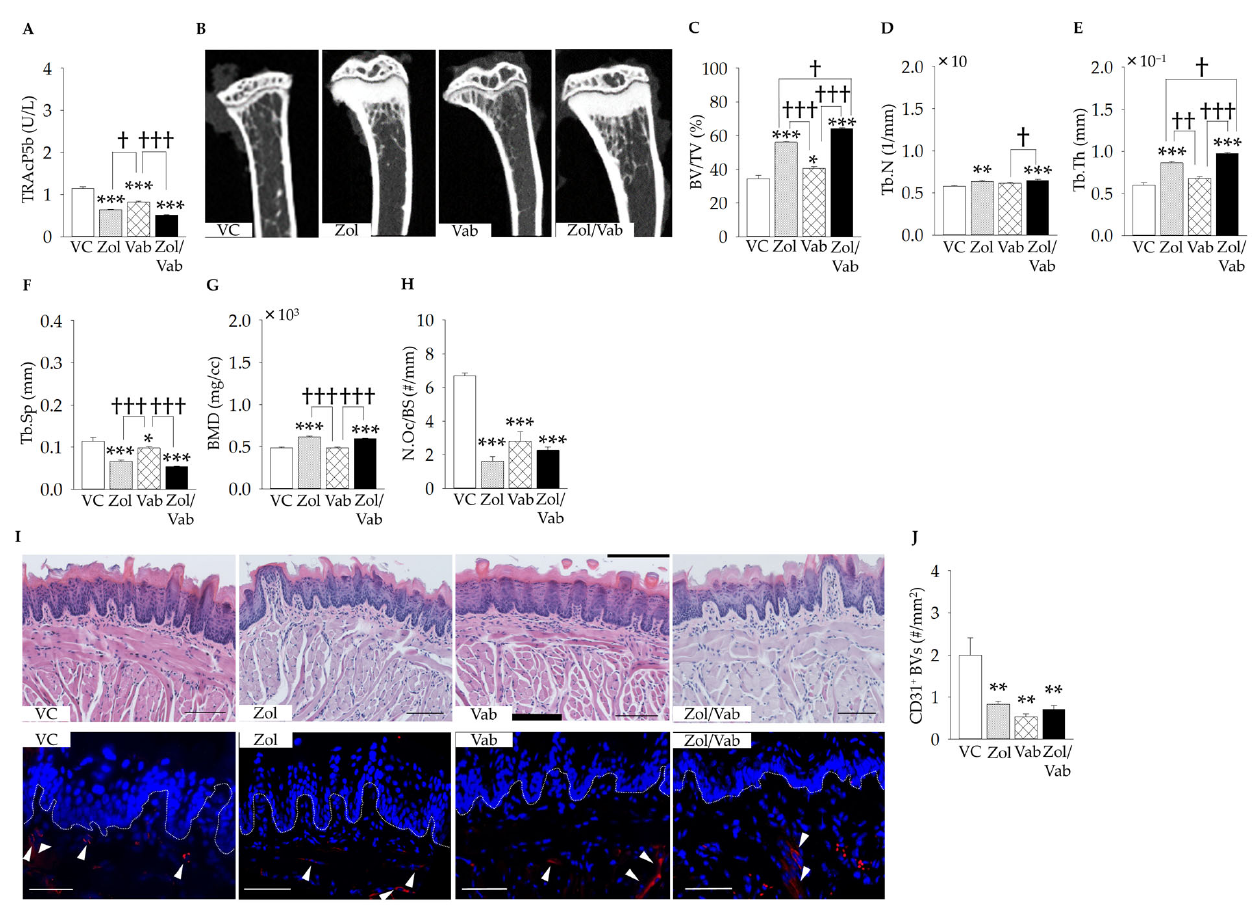
Figure 2. Effects of administered drugs on systemic conditions. ( A ) Serum TRAcP5b levels are significantly lower in Zol, Vab, and Zol/Vab vs. VC, and in Zol and Zol/Vab vs. Vab. ( B ) Representative micro computed tomography images of the tibial metaphysis. ( C ) Bone volume per tissue volume (BV/TV) is significantly larger in Zol/Vab vs. other comparison groups, whereas BV/TV is significantly larger in Zol and Vab vs. VC, and in Zol vs. Vab. ( D ) Trabecular number (Tb.N) is significantly increased in Zol/Vab vs. VC and Vab, and Zol vs. VC. ( E ) Trabecular thickness (Tb.Th) is significantly greater in Zol/Vab vs. other comparison groups, whereas Tb.Th is significantly greater in Zol vs. VC and Vab. ( F ) Trabecular separation (Tb.Sp) is significantly smaller in Zol, Vab and Zol/Vab vs. VC, and in Zol and Zol/Vab vs. Vab. ( G ) Bone mineral density (BMD) is significantly greater in Zol and Zol/Vab vs. VC and Vab, although BMD is the same in Vab and VC. ( H ) The number of osteoclasts on the bone surface (N.Oc/BS) is significantly decreased in Zol, Vab, Zol/Vab vs. VC. ( I ) Representative hematoxylin and eosin-stained and immunofluorescent images of tongue tissue (white arrowheads: CD31 + cells, bar: 100 µ m). ( J ) The number of CD31 + blood vessels (CD31 + BVs) is significantly decreased in Zol, Vab, and Zol/Vab vs. VC. Graphs show means ± SEM. * p < 0.05, ** p < 0.01, *** p < 0.001, † p < 0.05, †† p < 0.01, ††† p < 0.001; n = 5